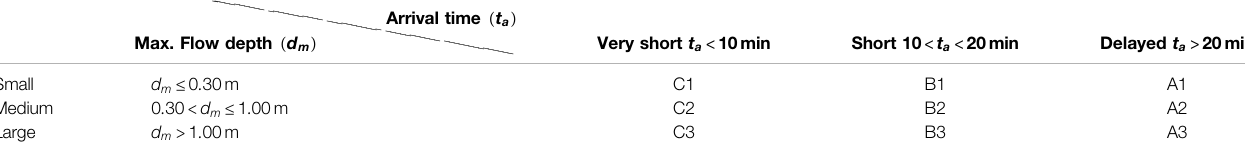
TABLE 1 | Classi fi cation of hazard